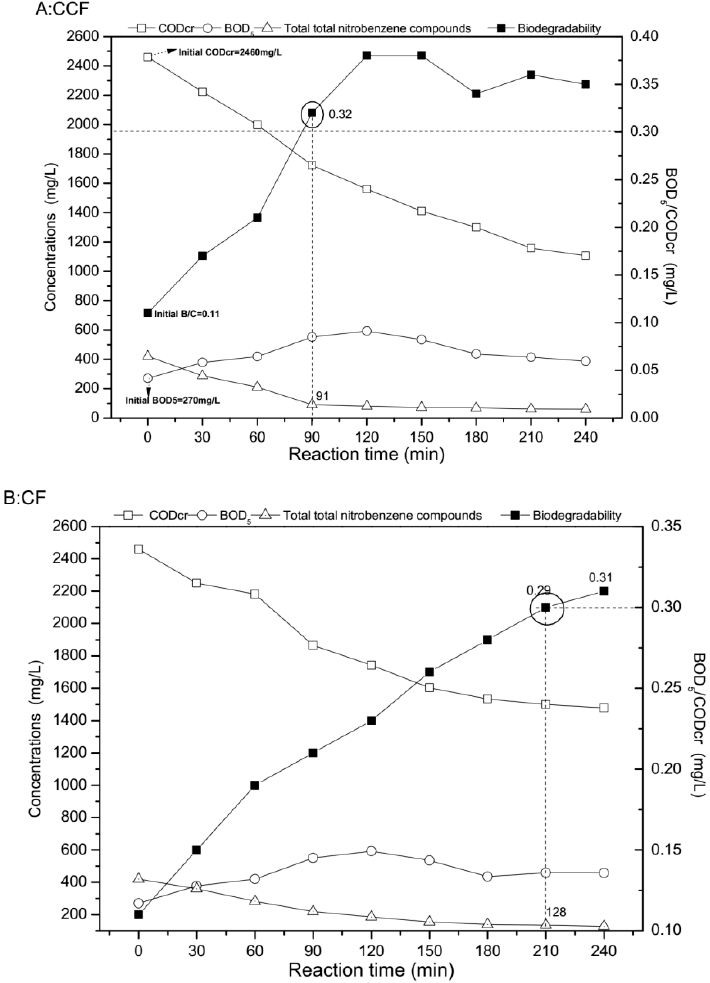
Figure 4. Effect of CCF and CF applied in comprehensive nitrobenzene compounds wastewater treatment. Table 1. Reaction kinetic fitting for the degradation of CODcr and